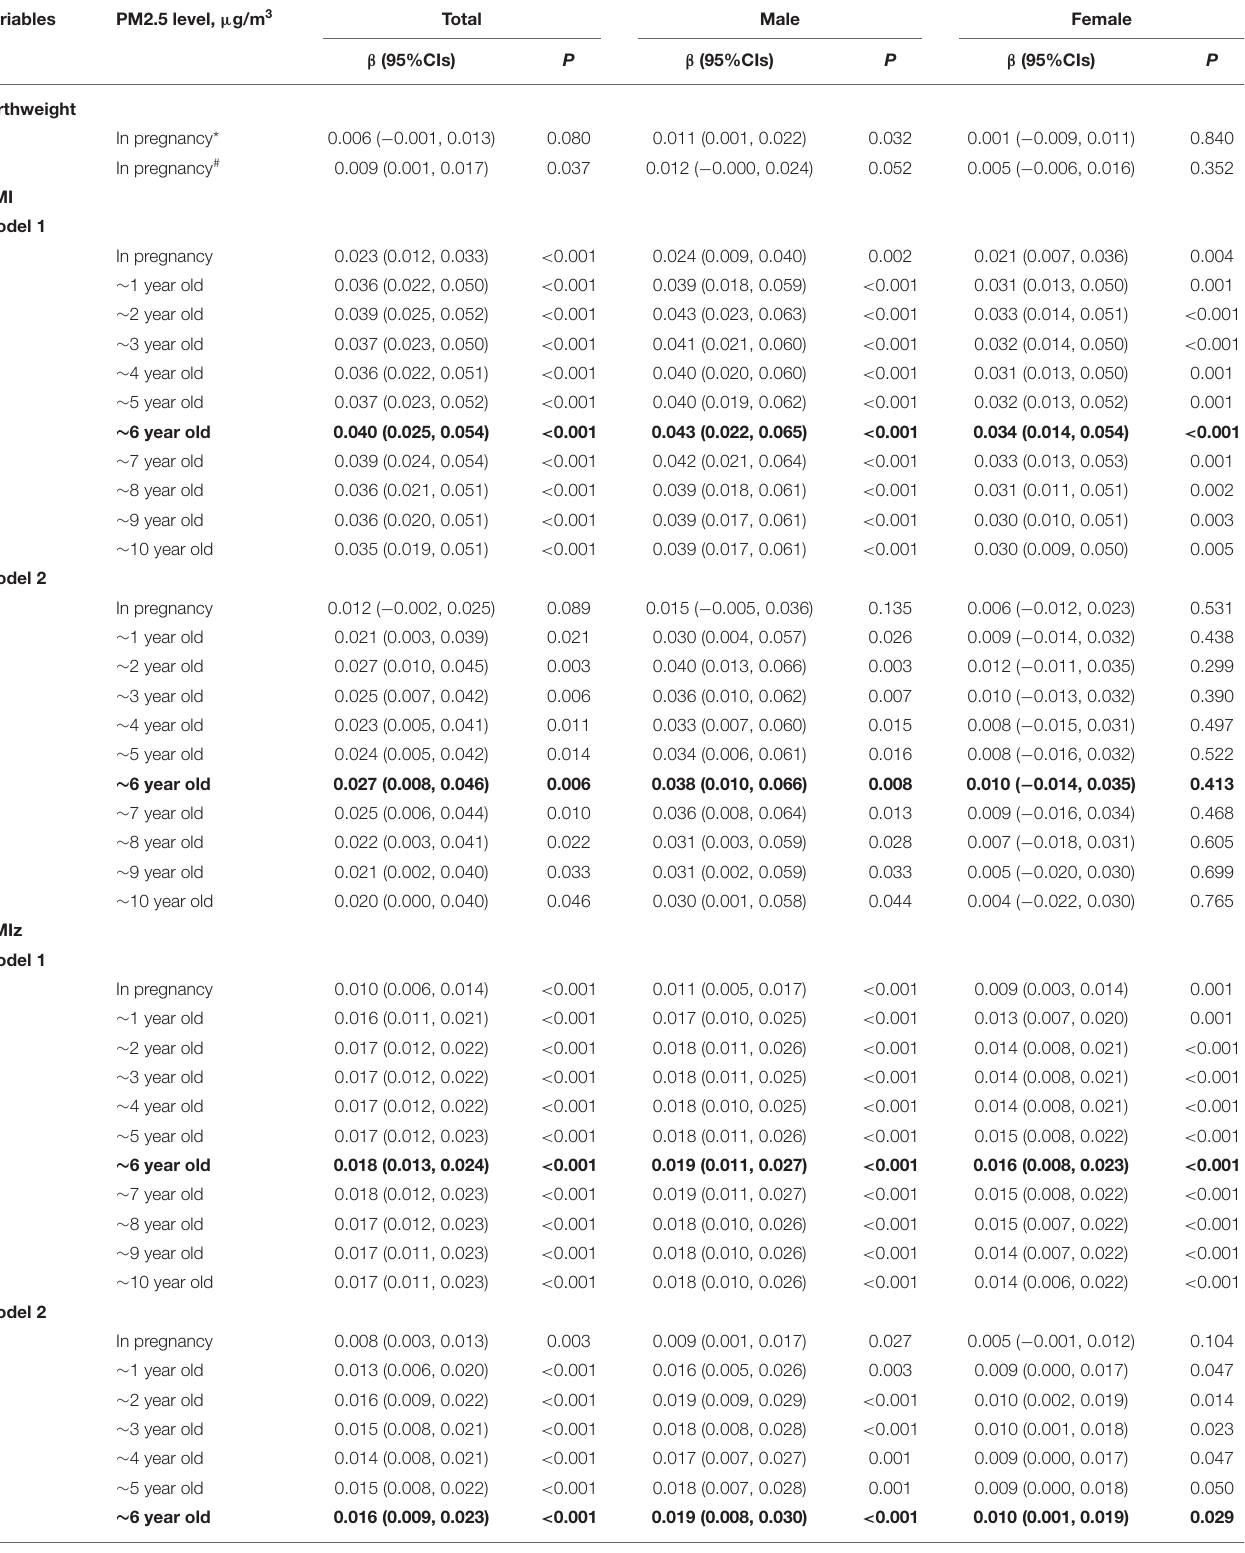
TABLE 4 | Association between different PM2.5 exposure duration and BMI/BMI Z /WHtR in children and adolescents.